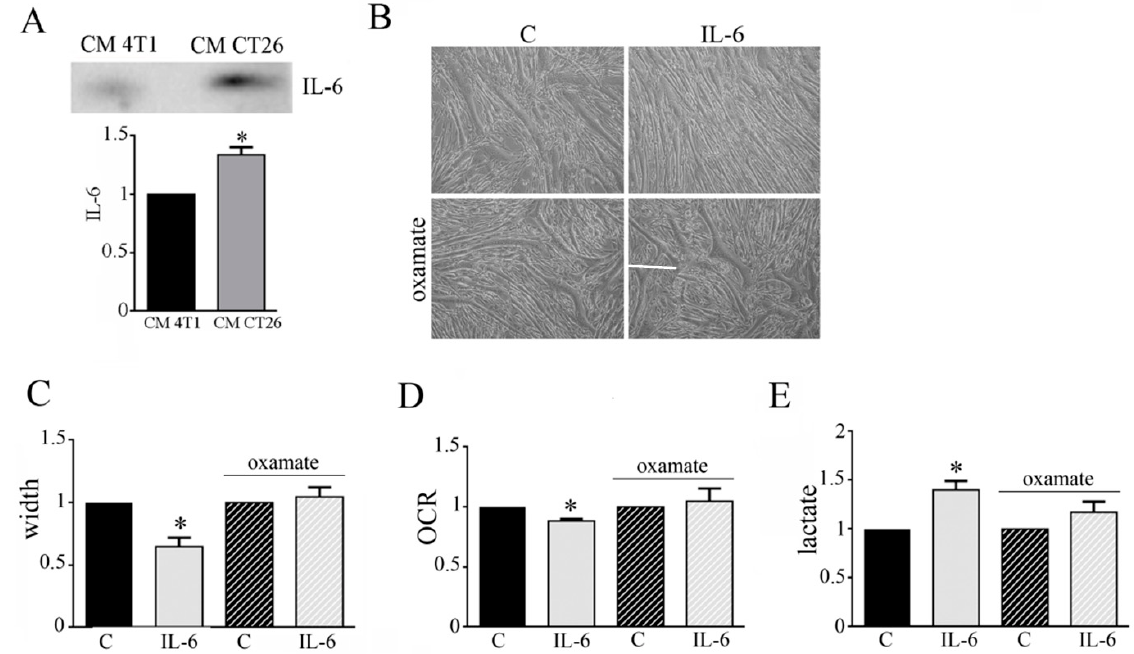
Figure 5. IL-6 secreted by CT26 colon carcinoma cells participates in metabolic shift leading to cachexia. ( A ) Anti-IL-6 immunoblot analysis performed in CM 4T1 and CM CT26. IL-6 level was normalized on CM protein content. Four-day- differentiated myotubes were treated with IL-6 (120 ng/mL) for 24 h, except untreated myotubes (indicated with C) that are maintained in differentiating medium for the same period. Where indicated, the LDH inhibitor’s oxamate (75 mM final) was added to the culture media. ( B ) Phenotypic effect due to IL-6 treatment in myotubes observed by optical microscope. Scale bar: 100 µ m. ( C ) Measure of myotube width in the presence of IL-6. ( D ) Oxygen consumption rate (OCR) analysis and ( E ) lactate assay. All the values in the bar graphs are reported as fold increase, considering control myotubes as 1; n = 4; * p < 0.05.